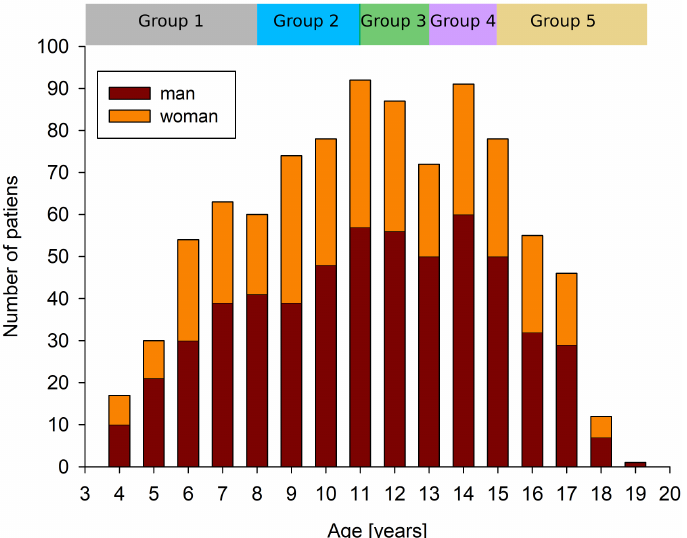
Figure 2. The data in groups with a similar number of samples were divided proportionally into training and validation datasets based on